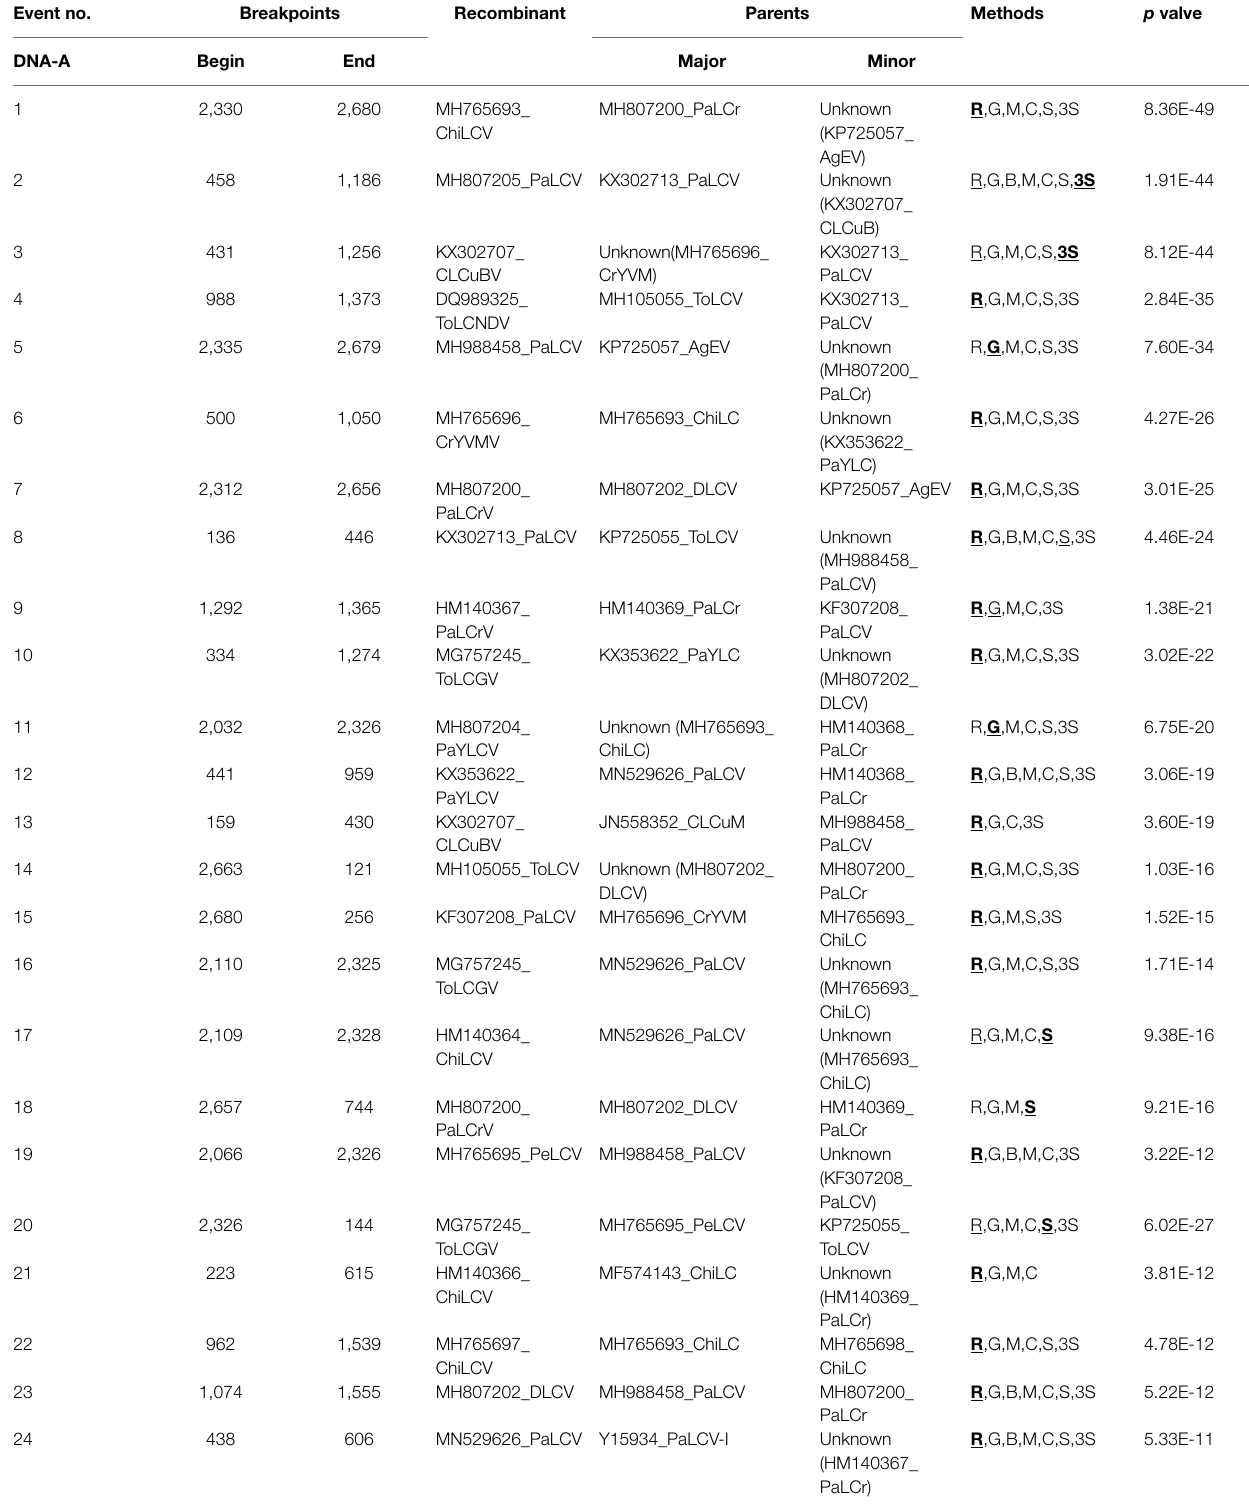
TABLE 3 | Putative recombination events detected using the RDP4.1 program among begomoviruses and betasatellites associated with PaLCD, based on provided datasets from India; 44 DNA-A sequence and 26 associated betasatellite. Event